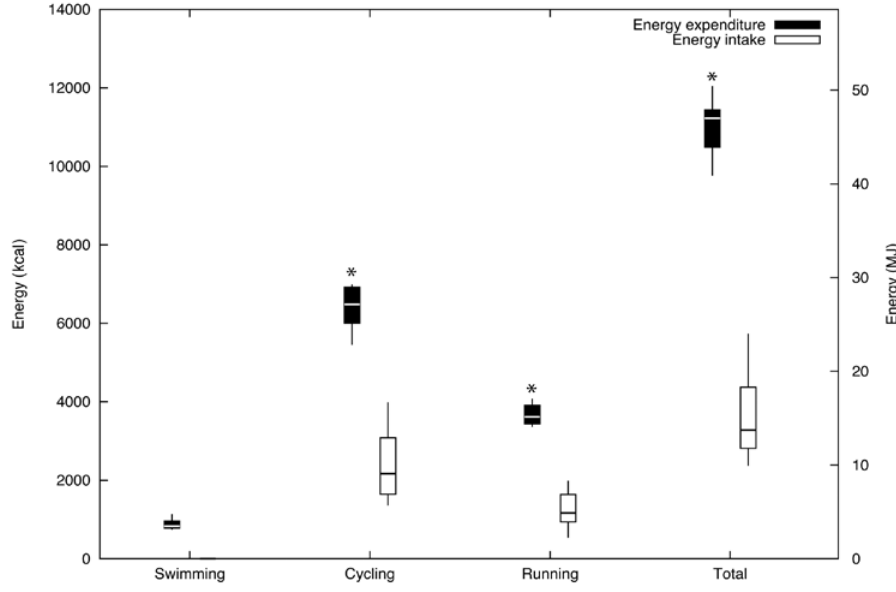
Figure 1. Swimming, cycling, running and overall energy intake and energy expenditure. Data are smallest value, first quartile (Q1), median, third quartile (Q3) and largest value of